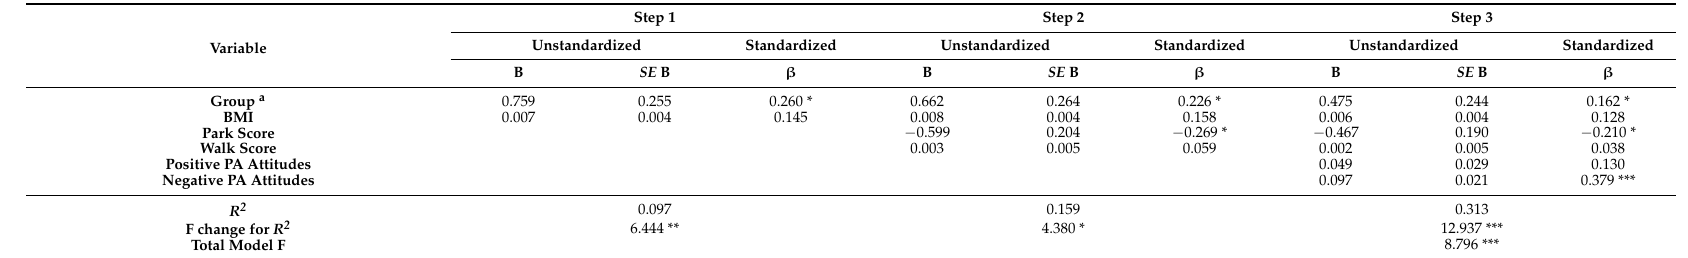
Table 3. Multiple regression model of child usual pain